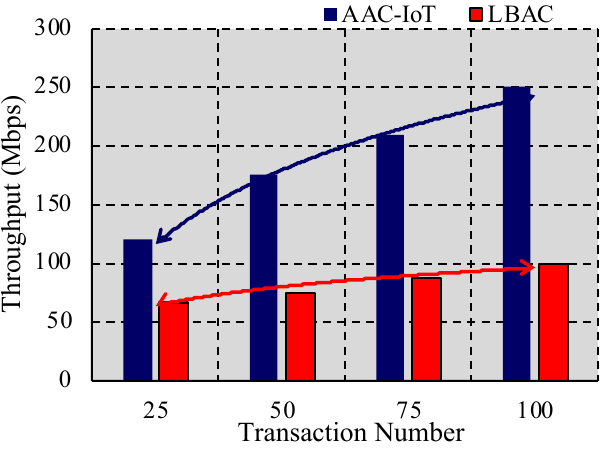
Figure 11. Performance of throughput plot against number of transactions.